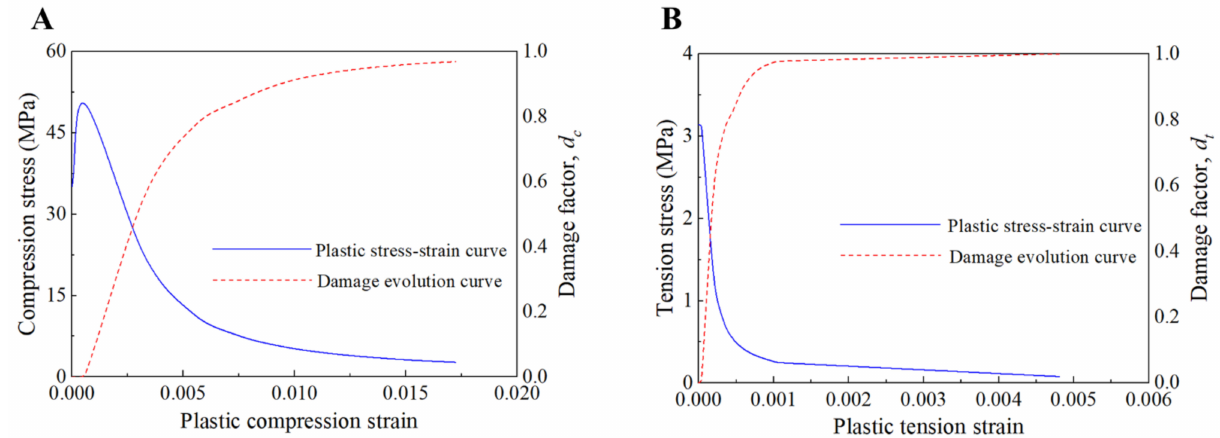
Figure 5. Plastic stress–strain curves and damage evolution curves of C80 concrete: ( A ) compression; ( B )